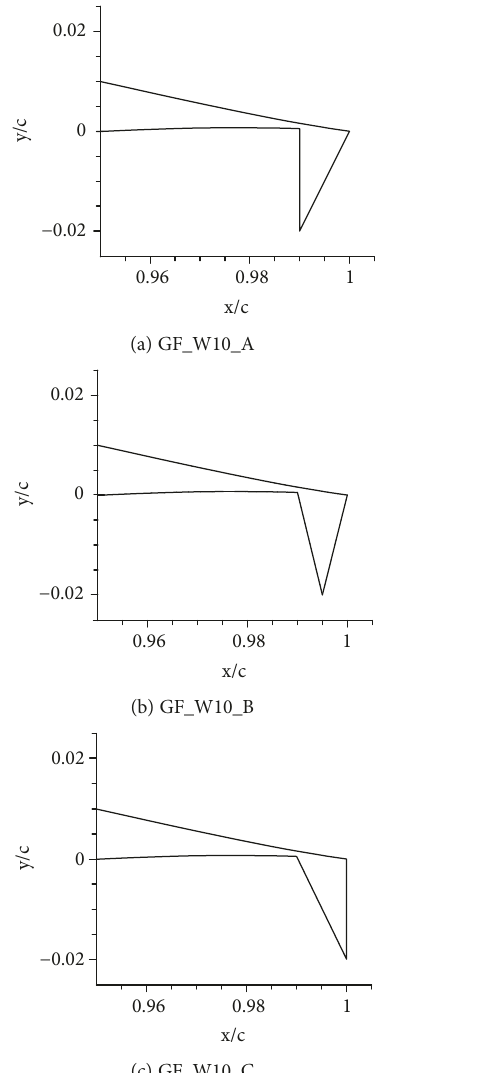
Figure 8: Schematic diagram of various Gurney fl ap shapes.